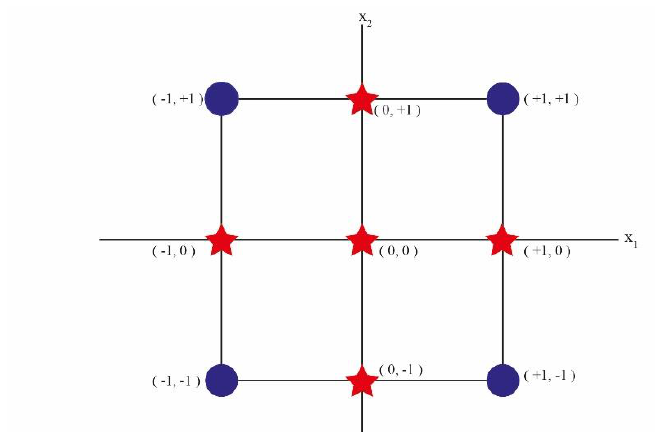
Figure 2. Central composite design for Face Centered Central Composite Model